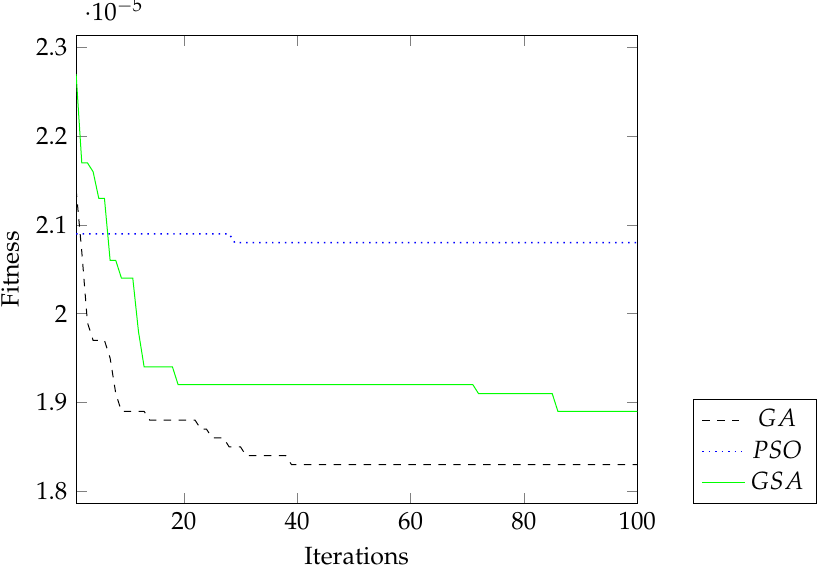
Figure 5. Convergence curves of the 15 kVA single-phase transformer using the GA, PSO and the GSA methods.